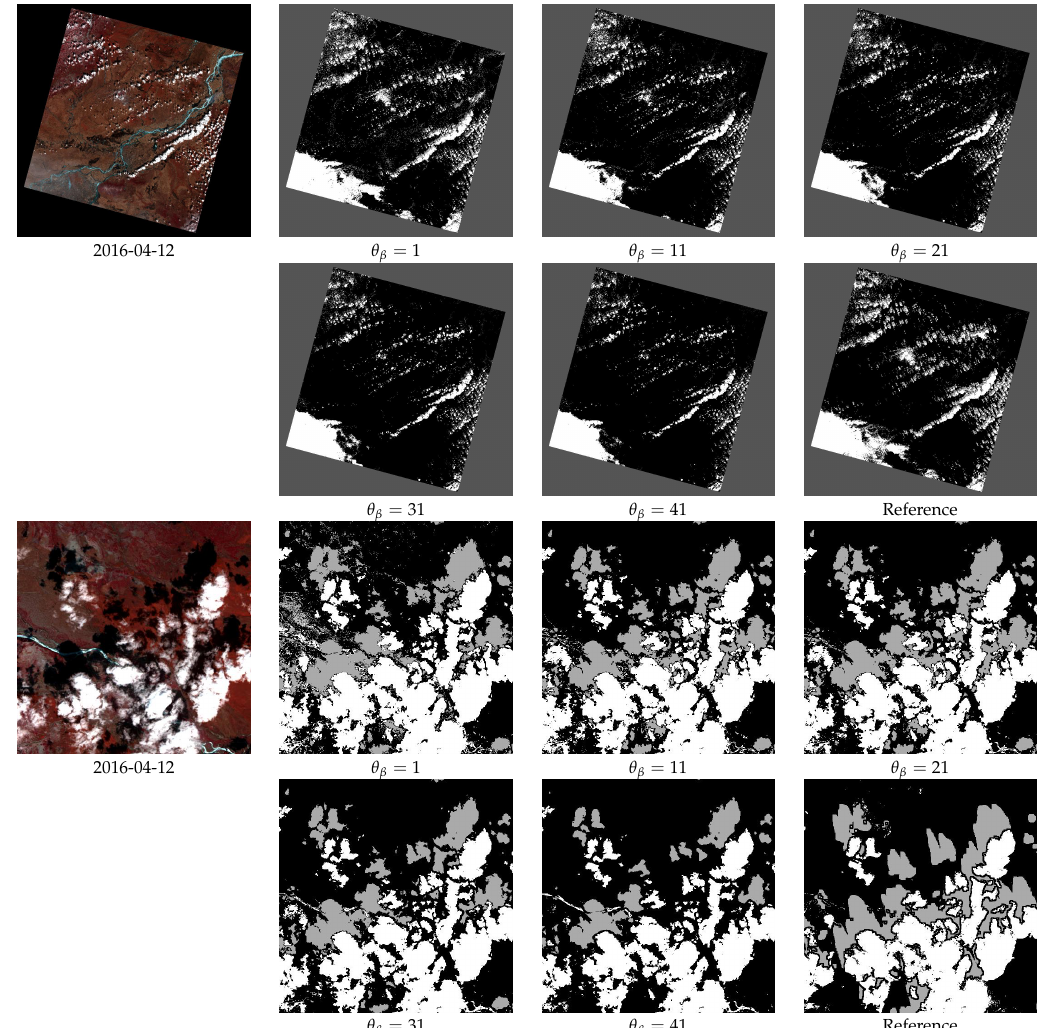
Figure 11. Visualizations with regards to θ β of Dense CRF postprocessing. The candidate values of θ β vary from 1 to 41 while θ α and θ γ are secured to 91 and 3. Isolated regions can be removed if a higher θ β is